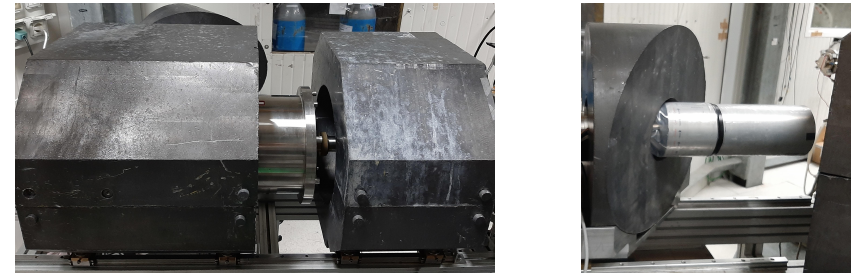
Figure 2: Left: BGO detector in lead shielding, partially retracted (shielding open) to access target. Right: HPGe detector, here shown retracted (fully outside of the shielding) at 55 ◦ to the